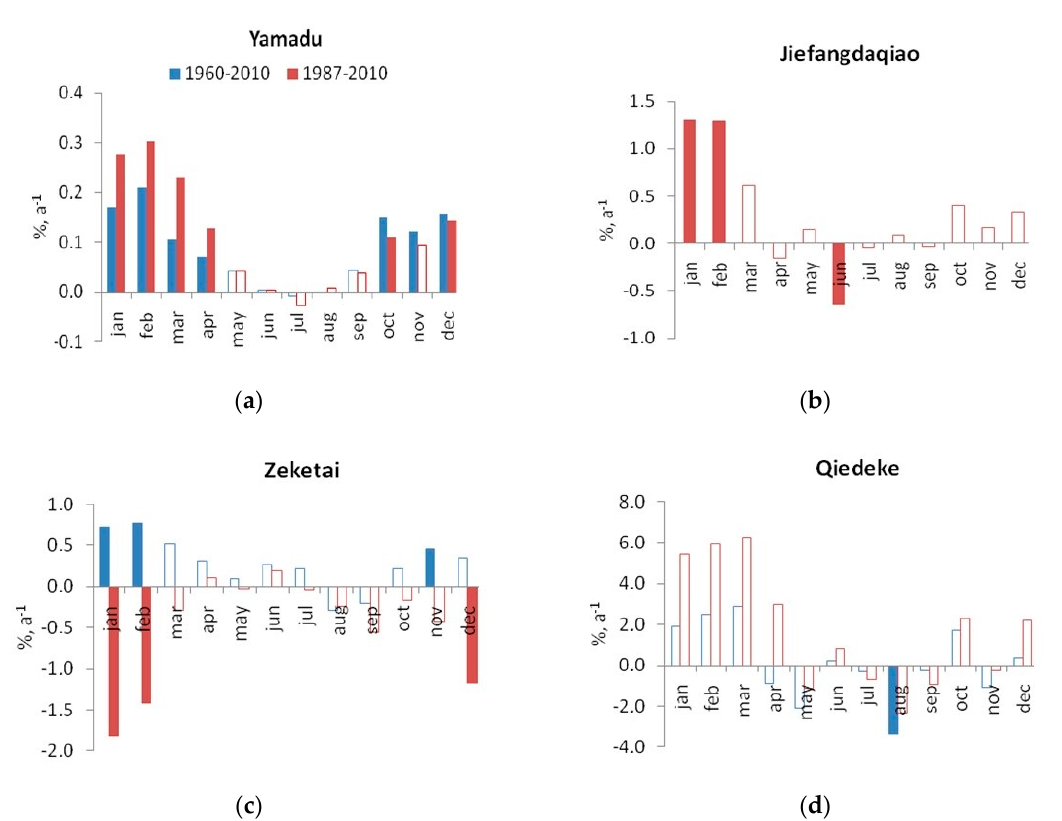
Figure 10. Trends in monthly streamflow (% a − 1 ) over the two periods of individual records calculated using the Mann-Kendal test for Yamadu ( a ), Jiefangdaqiao ( b ), Zeketai ( c ) and Qiedeke ( d ) stations. Solid bars represent trends significant at 0.05 confidence level. Different scales are used for different rivers.